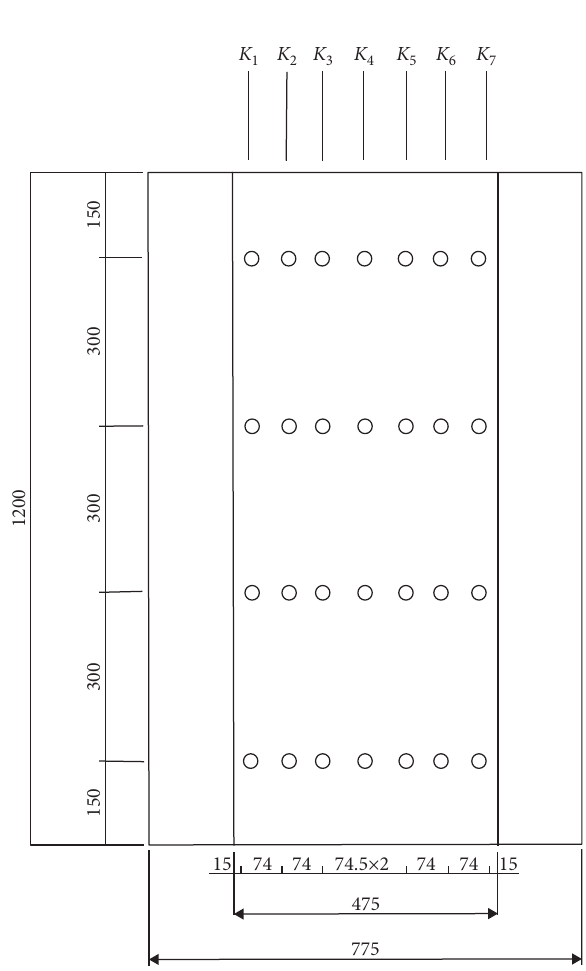
Figure 2: Undersurface of the model (unit: